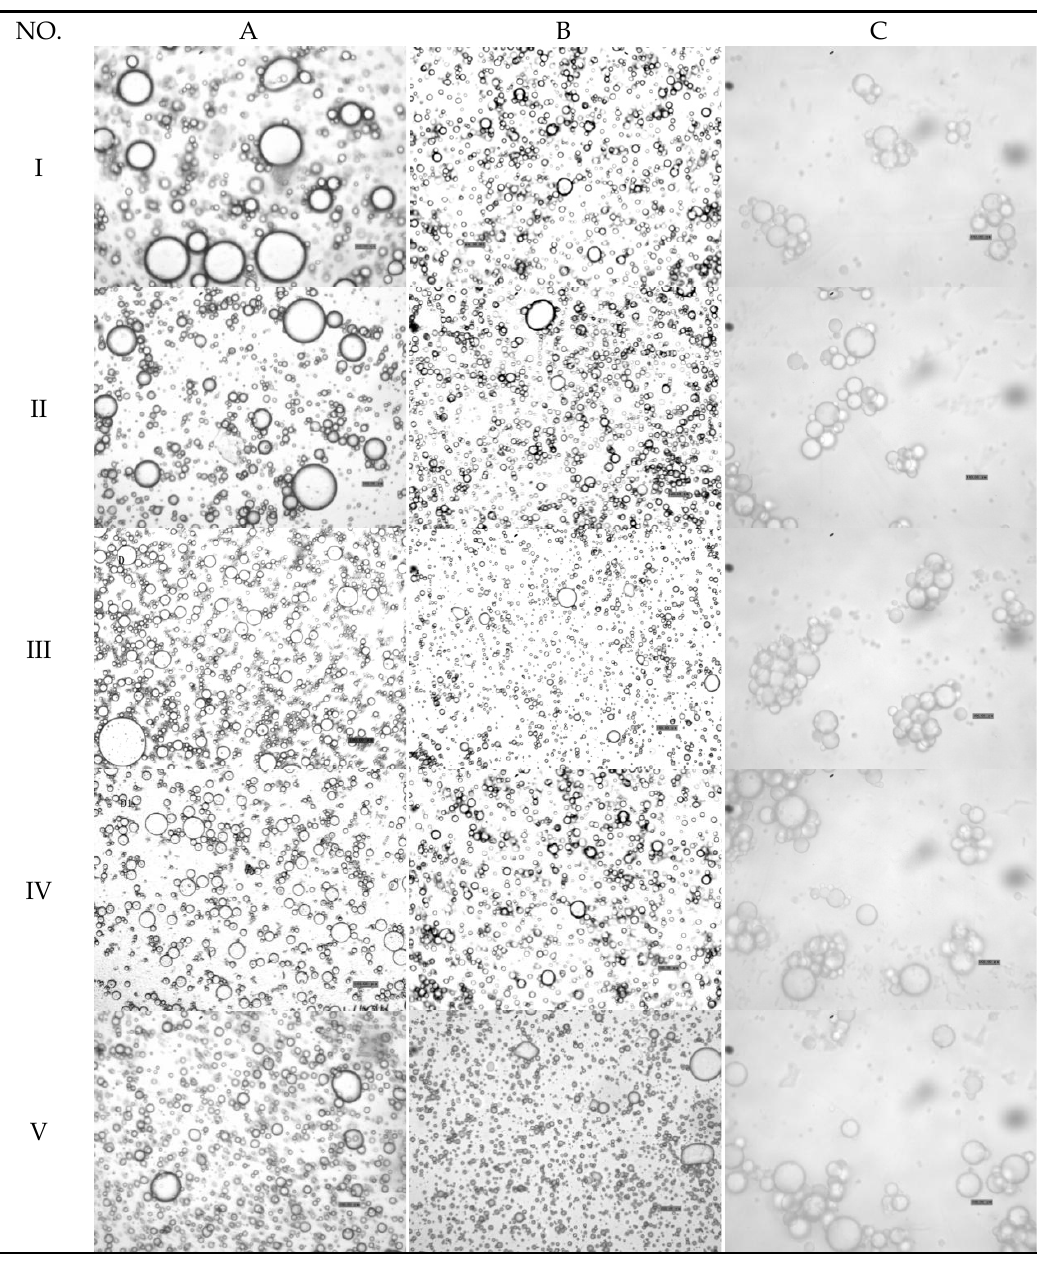
Figure 4. ( A ) Microphotographs of primary emulsions I, II, III, IV, and V represent protein content of 0.8 g/100 g, 1.8 g/100 g, 2.8 g/100 g, 3.8 g/100 g, and 4.8 g/100 g). ( B ) Secondary emulsions (protein content was 3.8 g/100 g; I, II, III, IV, and V represent SBP content of 0.01 g/100 g, 0.02 g/100 g, 0.05 g/100 g, 0.10 g/100 g, and 0.15 g/100 g, respectively). ( C ) Laccase-treated secondary emulsions (protein content was 3.8 g/100 g; SBP content was 0.10 g/100 g; I, II, III, IV, and V represent laccase content of 2 U/100 g, 4 U/100 g, 6 U/100 g, 8 U/100 g, and 10 U/100 g, respectively). Scale bar represents 10 μ m.